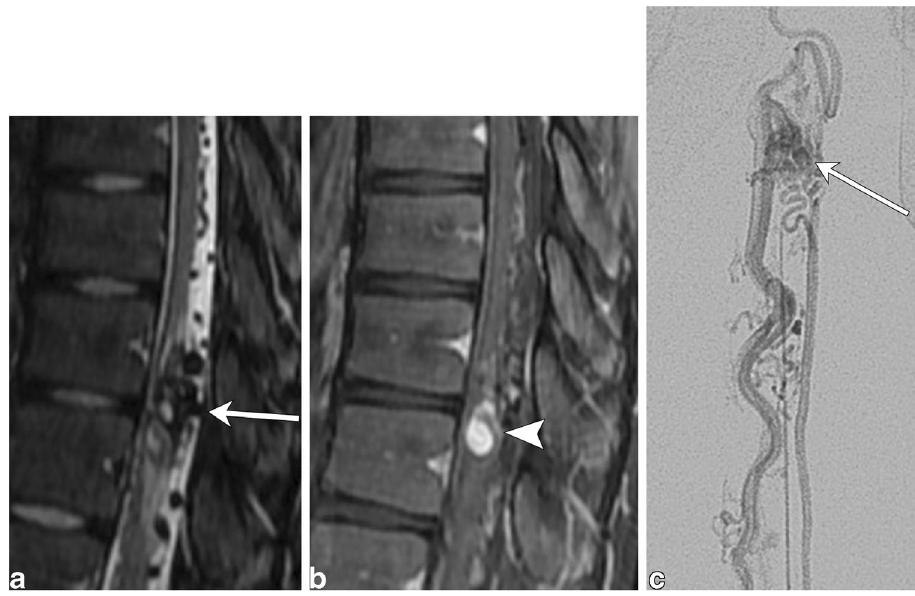
Fig. 20 Arteriovenous malformation. A 16-year-old male with left leg weakness and progressive areflexia. a Sagittal T2 fat-saturated image demon- strates a conglomeration of flow voids within the cord parenchyma with surrounding hyperintensity.